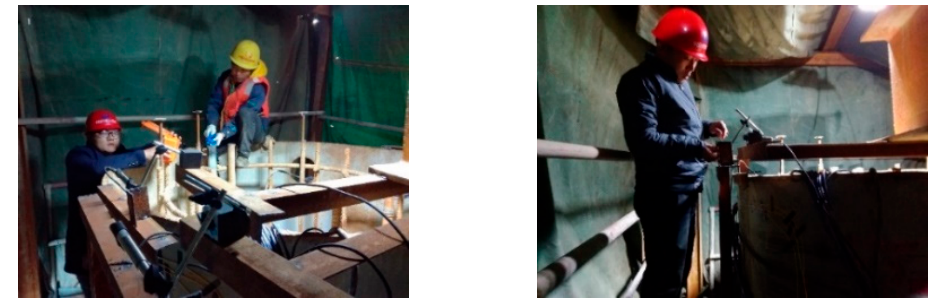
Figure 11. Displacement data at + 10.5 m elevation collected by the dial indicators during the test.